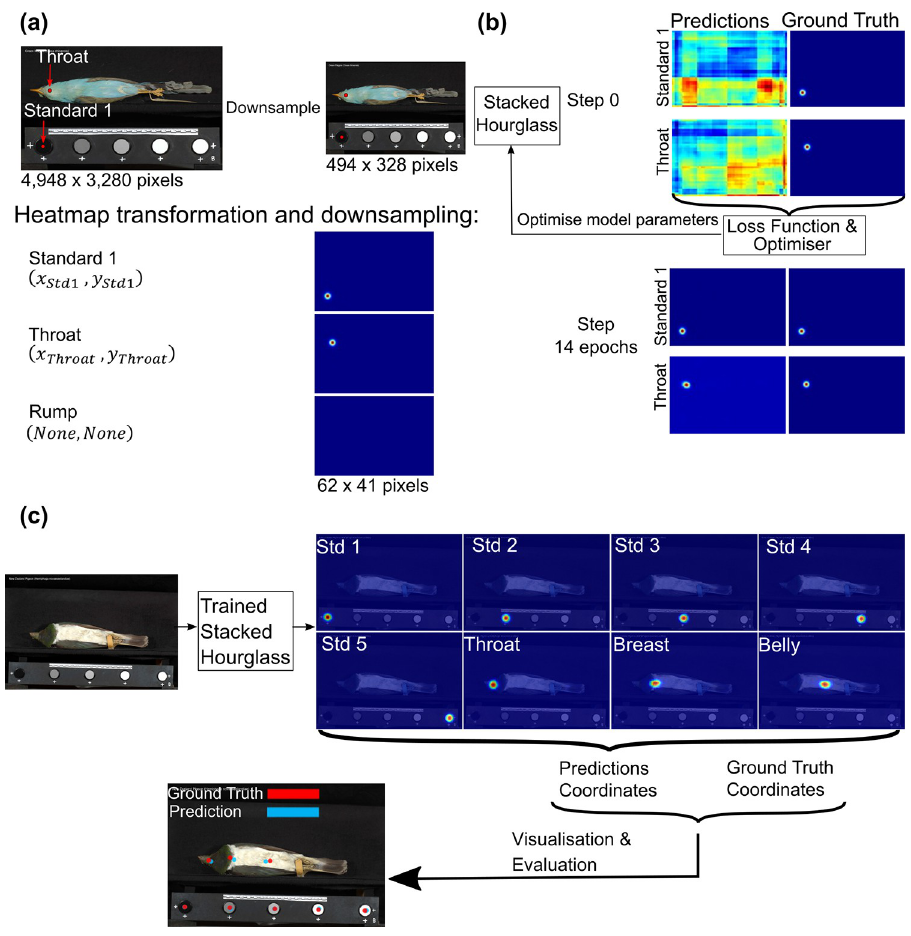
Fig 2. The pipeline of applying the Stacked Hourglass model to predict points on the avian specimen dataset. (a) A data pre-processing step resizes images (from 4948 x 3280 pixels to 494 x 328 pixels) and transforms point coordinates into heatmaps (62 x 41 pixels). (b) This pre-processed training data is then used to train the network. Output heatmaps iteratively become closer to ground truth during training. (c) The trained network is used to generate predictions of point locations for validation images. These are then post-processed (transforming heatmaps back to coordinates) and evaluated.